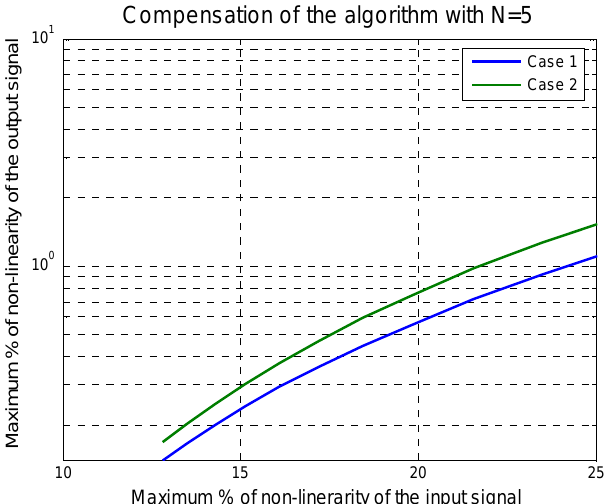
Figure 3. Algorithm response with five points of adjustment.